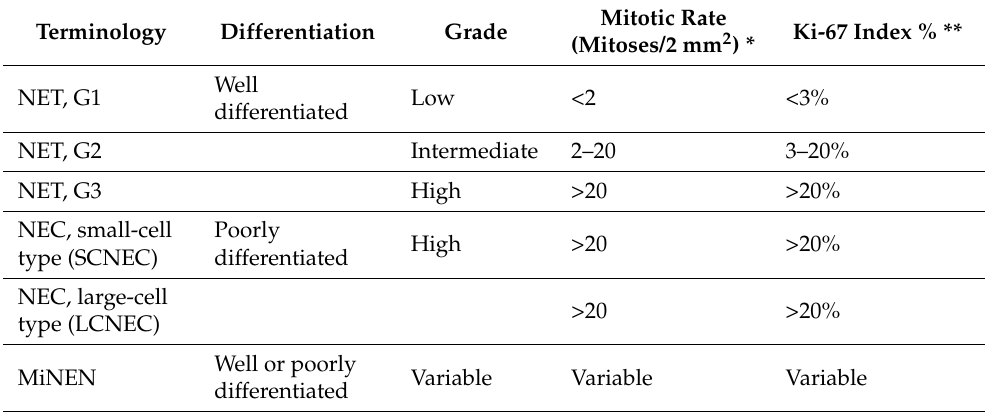
Table 1. Classification for gastroenteropancreatic neuroendocrine neoplasms